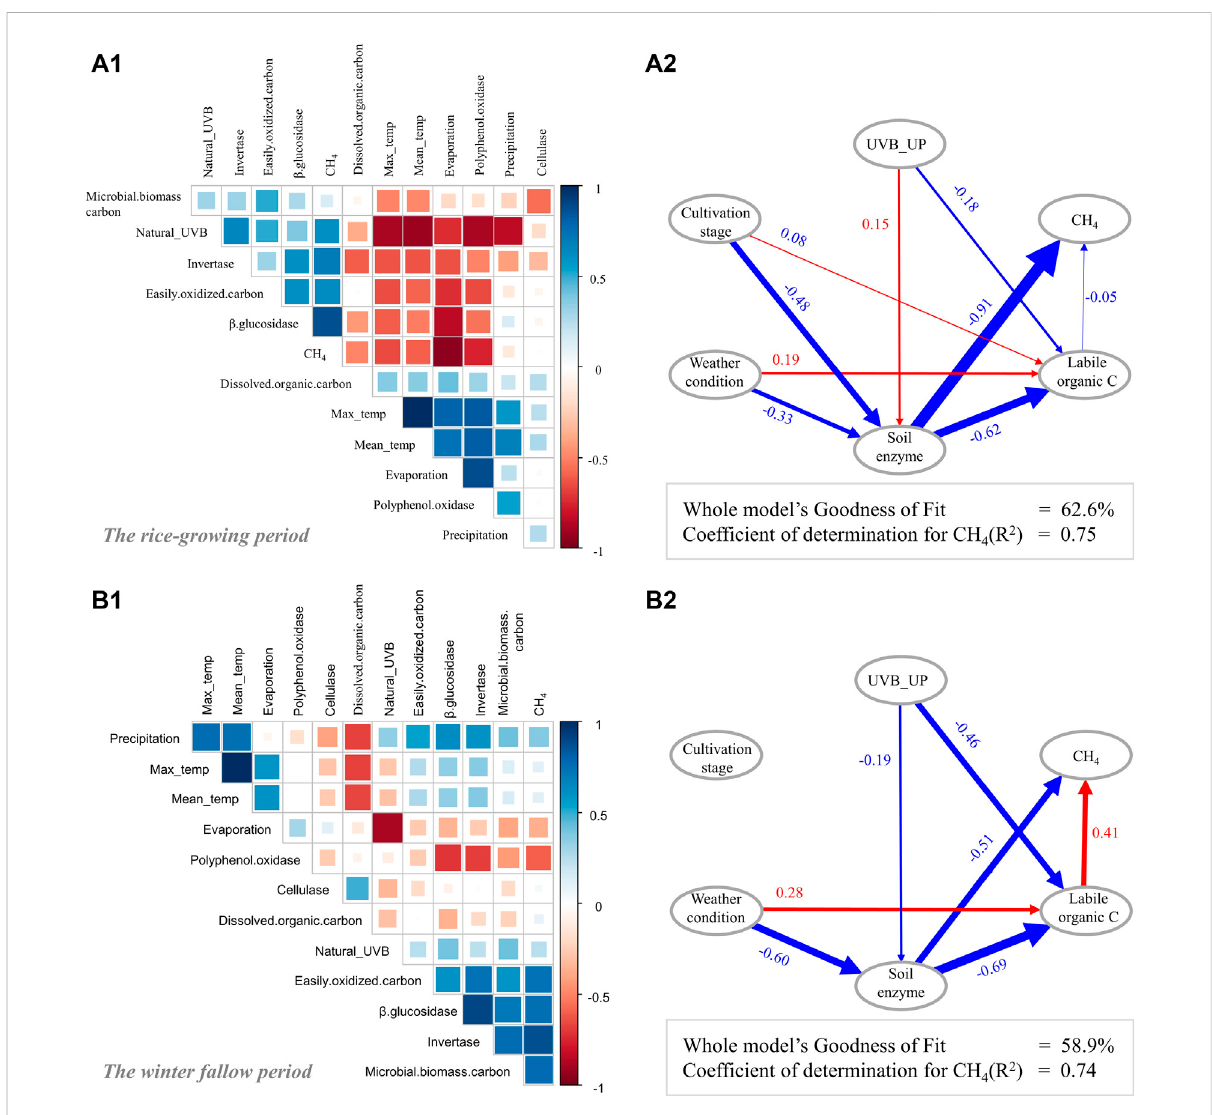
FIGURE 3 Correlation coef fi cients among C transformation enzymeactivities, labile organic carbon contents and CH 4 emissions during the rice-growing period (A1) and thewinter fallow period (B1) . Partial least squares path analysis for CH 4 emissionsduring therice-growing period (A2) and the winter fallow period (B2) , showing the relationships among cultivation stage, weather conditions (including temperature, precipitation, and evaporation), enhanced UV-B, and the corresponding pathway to driving CH 4 emissions. The coef fi cient of determination ( R 2 , %) to each microbial feature and the model ’ s goodness of fi t (GoF, %) are